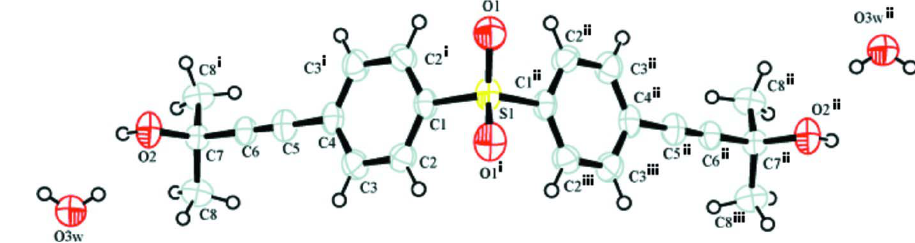
Figure 1 The molecular structure of the title compound, with displacement ellipsoids drawn at the 30% probability level [symmetry codes: (i) = x, 1-y, z; (ii) = 1-x, 1-y, z; (iii) = 1-x, y,